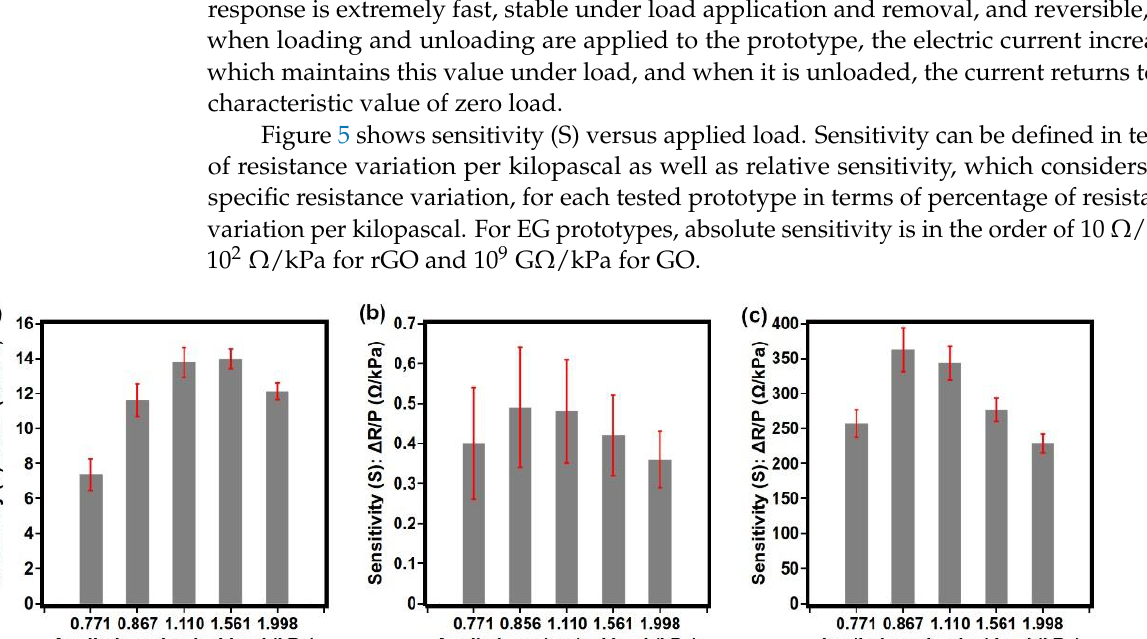
Table 2. Relative sensitivity, s , of sensor prototypes and their respective standard deviations [%